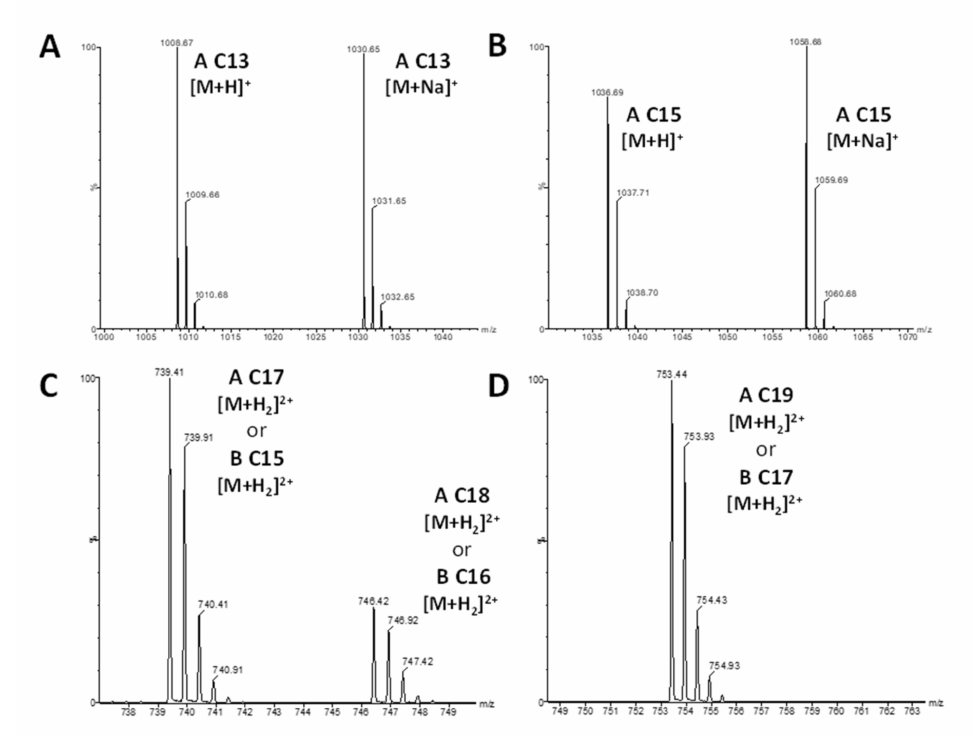
Figure 5. Mass spectra of surfactin ( A , B ) and plipastatin ( C , D ) from LC-HRMS analysis of supernatant sample of B. subtilis (strain 23) after 48 h culture in KB